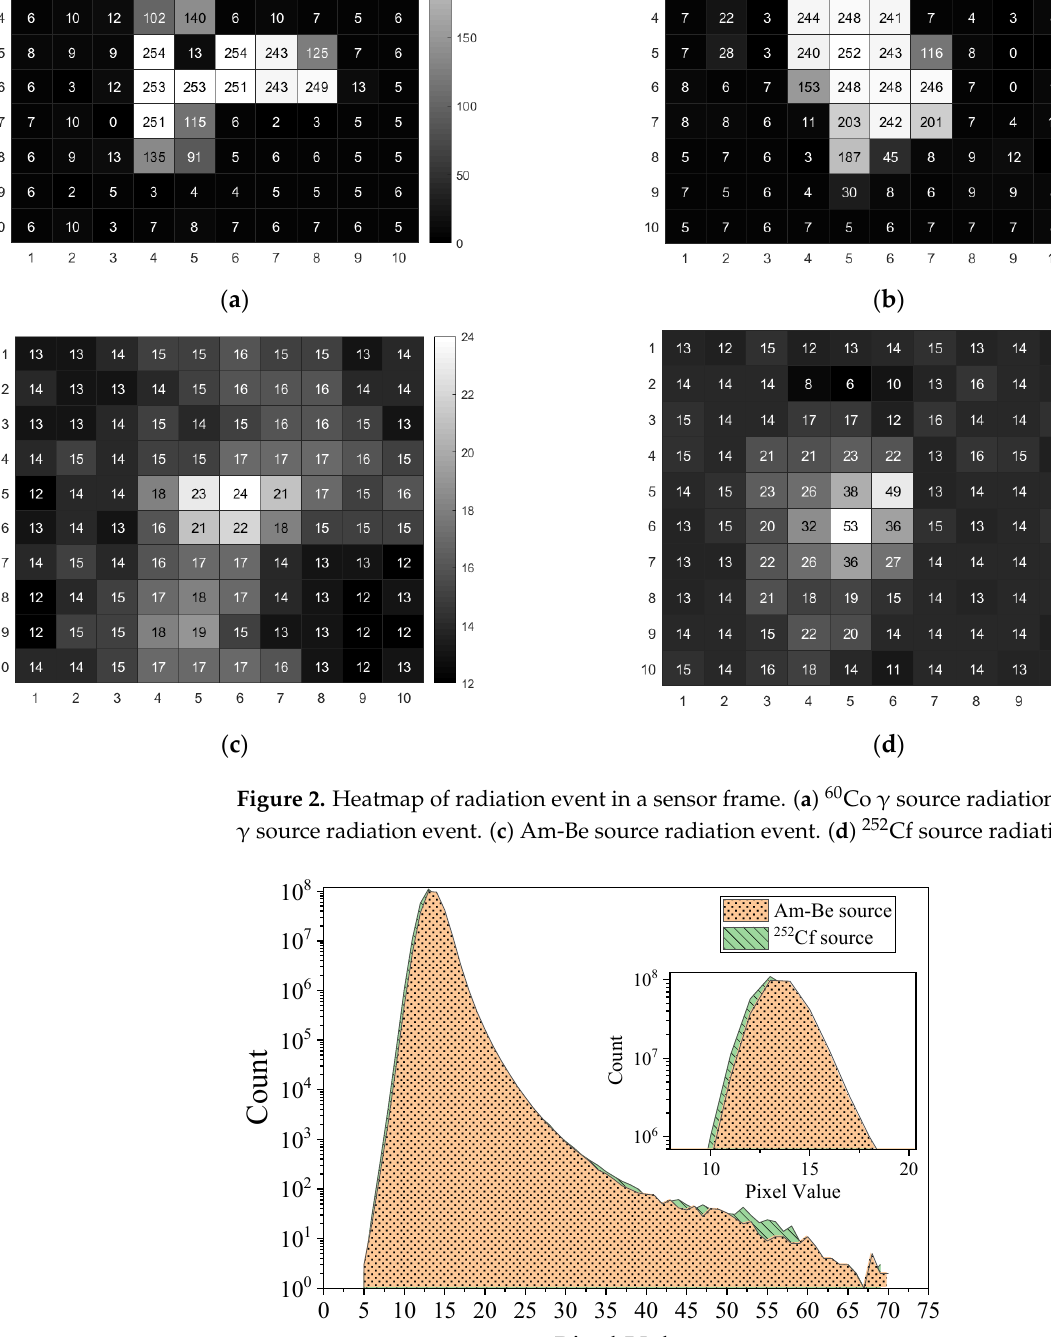
Figure 3. Histogram of Am-Be and 252 Cf source radiation signals of the sensor.